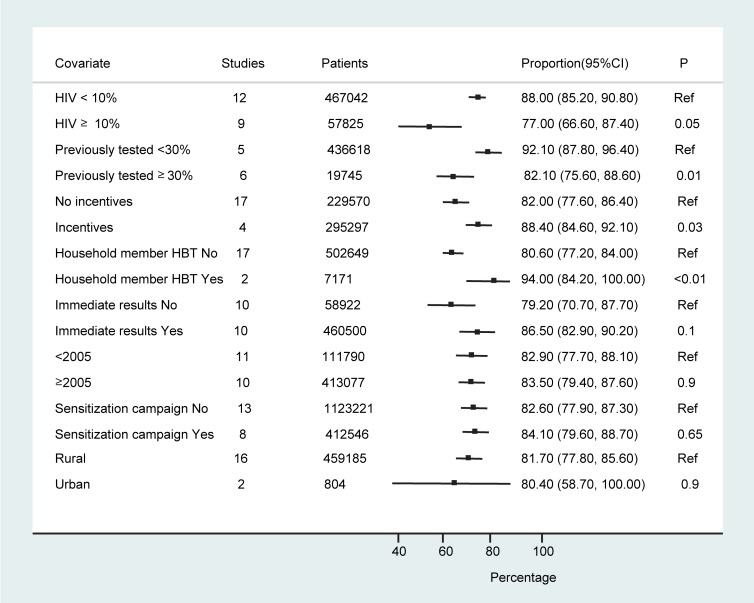
Sub-group analyses.